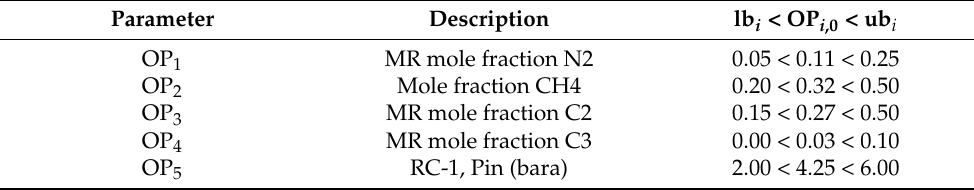
Table 5. Summary of Optimization Parameters with Initial (OP i ,0 ) and Constraint Values. Parameter